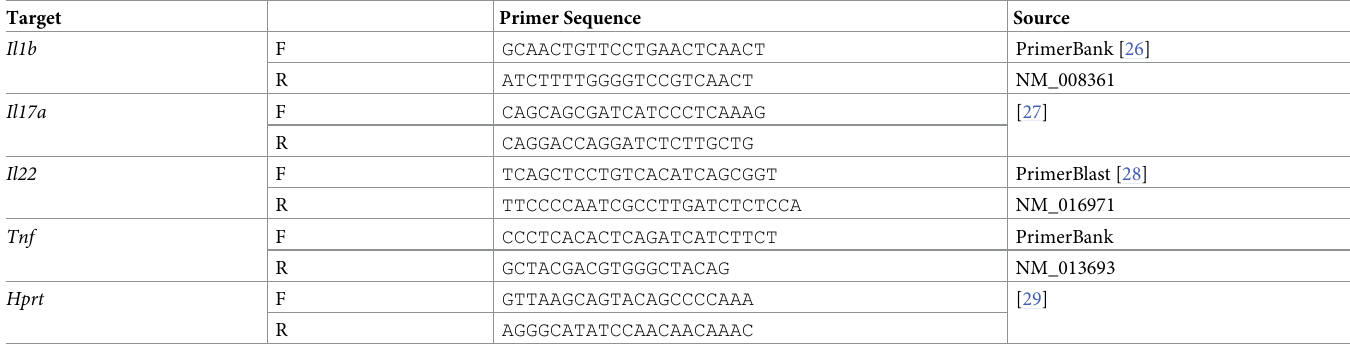
Table 2. Primers for